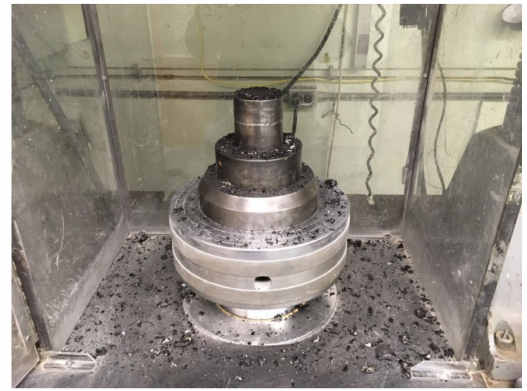
Figure 6. Strain rates versus time graphs for the coal sample compressed at 17.01 MPa: ( a ) axial strain rate (r a ); ( b ) radial strain rate (r r ); ( c ) volumetric strain rate (r v ).